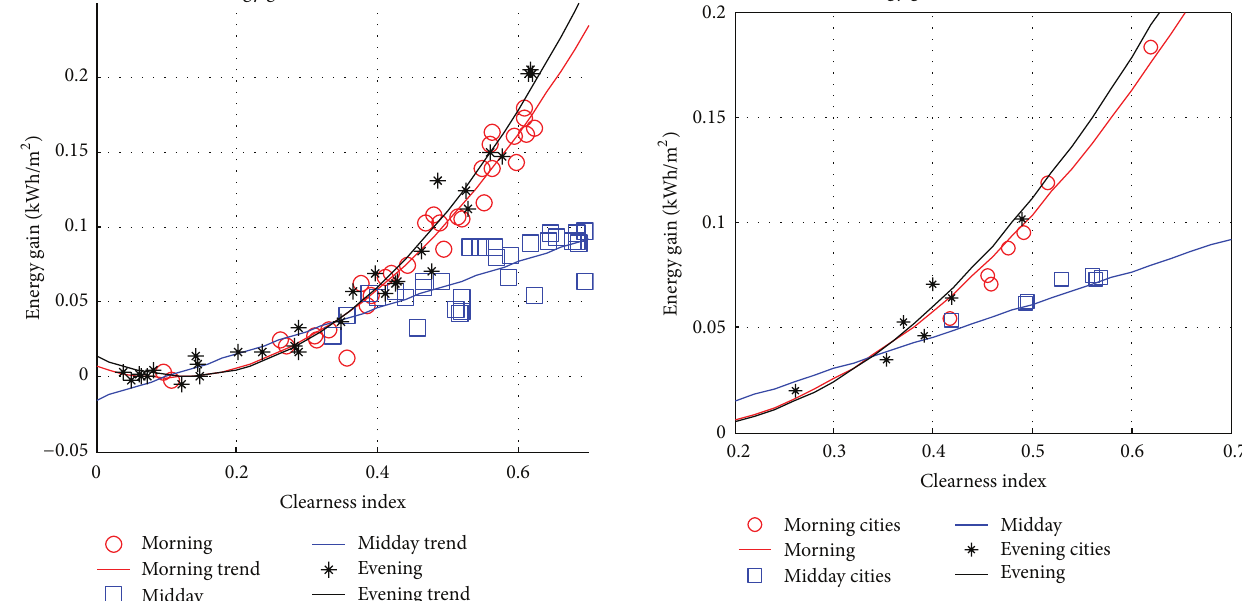
DAST and SSS can be converted from the global irradiation, respectively, by using the average effectiveness of the PV panel on DAST and SSS, 0.15. The energy generated for both systems in a year are being averaged into a mean daily energy generated and divided into three segments. Subsequently, average energy gain of DAST over SSS on the three periods can be obtained by using the mean energy generated for both systems in three segments.